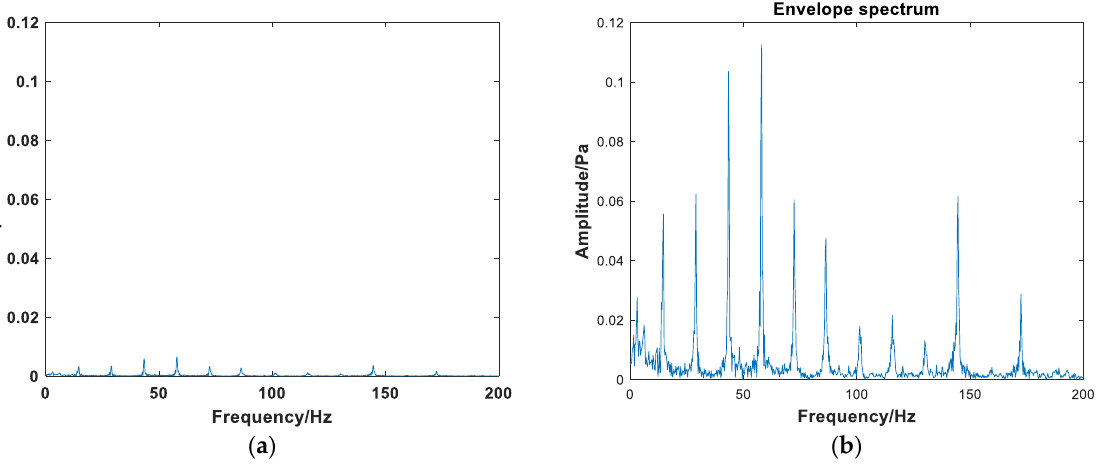
Figure 2. ( a ) Spectrum diagram of the Robinson R44 helicopter at 0.89 km; ( b ) envelope spectrum diagram of the Robinson R44 helicopter at 0.89 km.